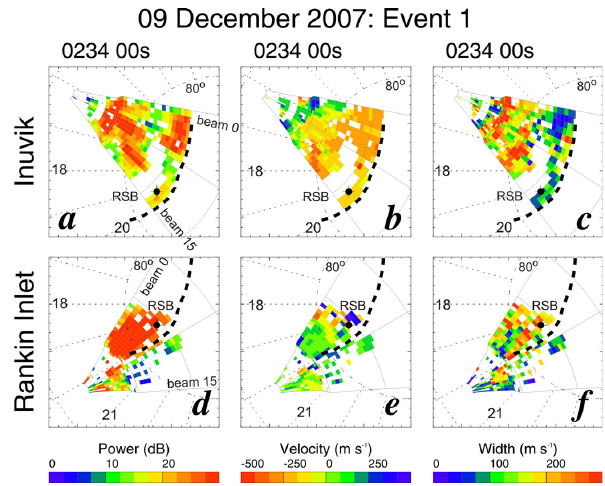
Fig. 4. (a) – (c) Inuvik and (d) – (f) Rankin Inlet radar maps of the echo power, velocity and spectral width for the scan which started at 02:34UT (event 1). Mapping is done in MLAT-MLT coordinates. Range ticks within the radar field-of-view correspond to gates 15, 30, and 45. Dashed lines indicate locations of the polar cap